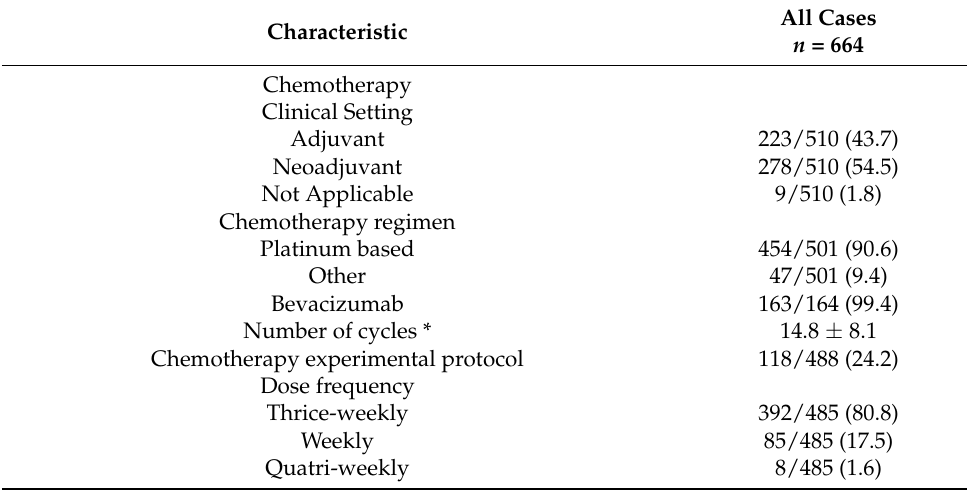
Table 2. Treatment and oncological outcome of the study